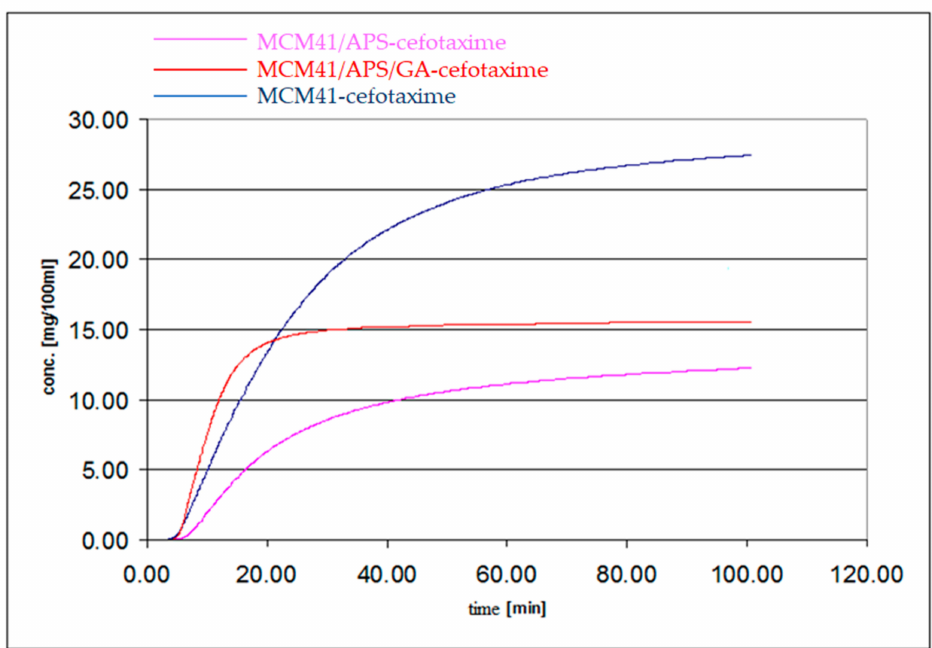
Figure 10. Desorption profiles of cefotaxime on the three support